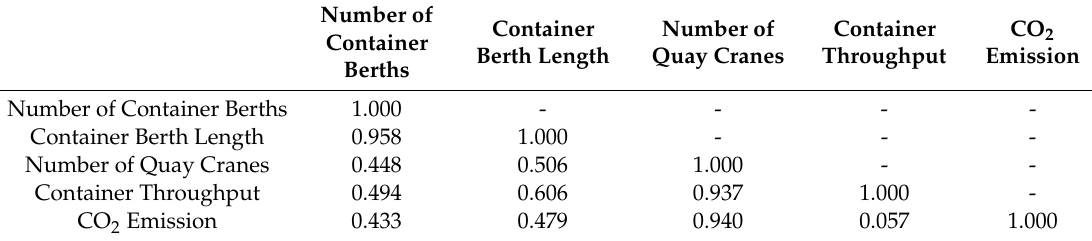
Table 4. Pearson correlation coe ffi cients between input variables and outputs.